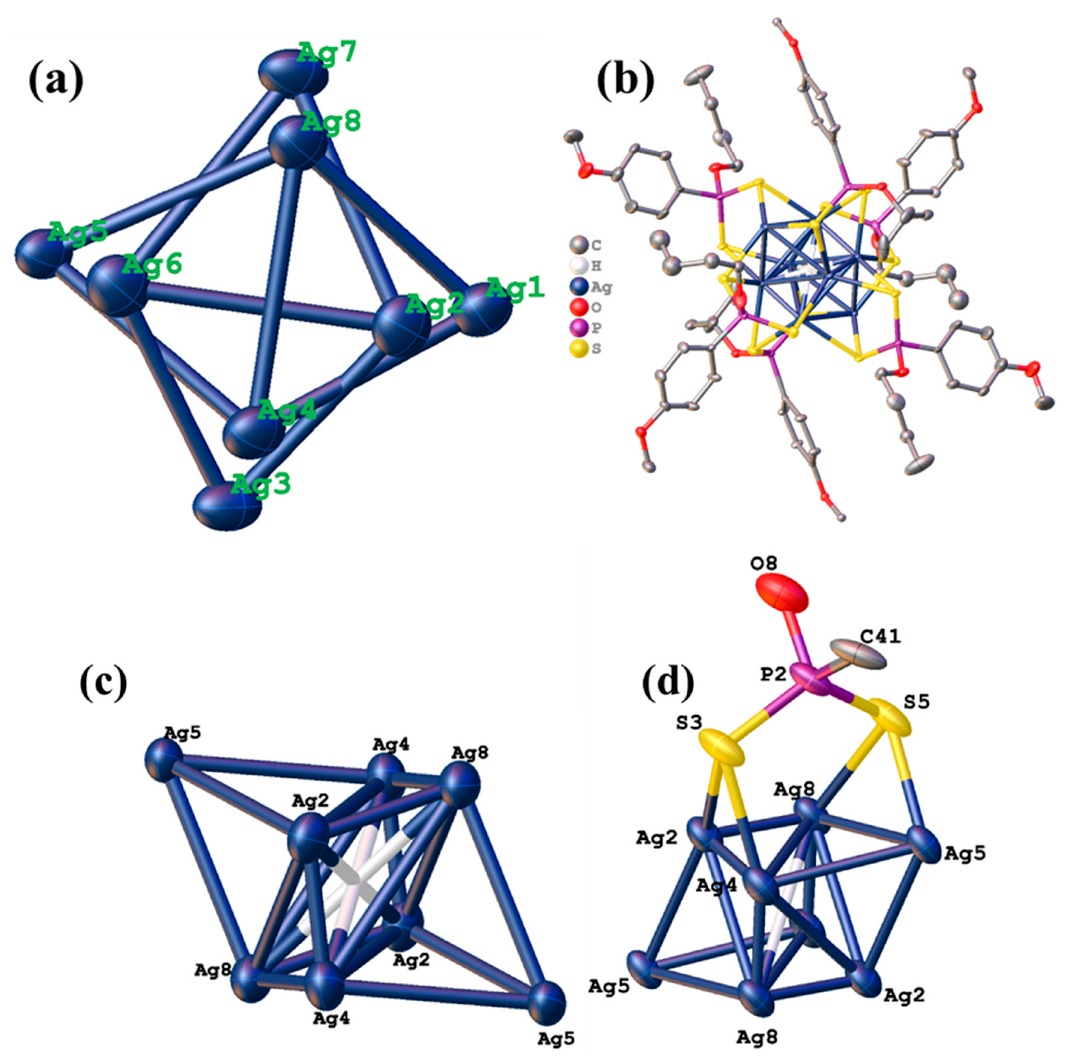
Figure 1. ( a ) Molecular structure of cluster 1 . H-atoms omitted for clarity except for the interstitial hydride. ( b ) Molecular representation of the asymmetric unit for 1 showing only the silver atoms. ( c ) Ag 7 H core structural representation. ( d ) Coordination motif of DTP ligand to the silver core.